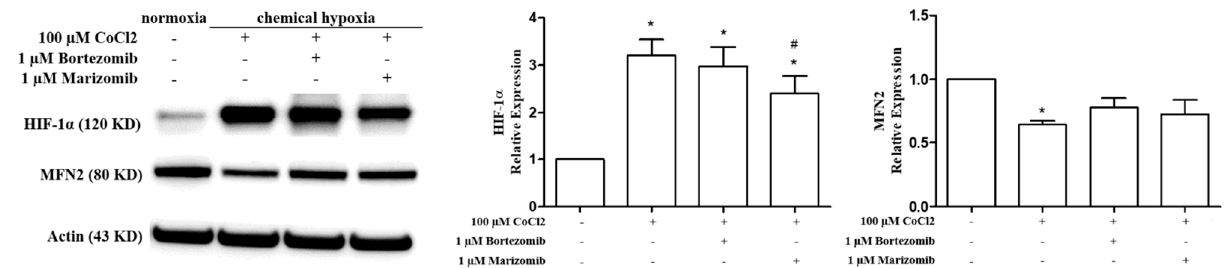
Figure 4. Proteasome inhibitors cannot obviously restore the expression of MFN2 inhibited by chemical hypoxia. HPASMCs were pretreated with 100 µ M CoCl 2 for 2 h, followed by bortezomib or marizomib for 24 h. The expressions of HIF-1 α and MFN2 were detected by Western blotting. Equal loading was confirmed with an anti-actin antibody. The expressions of HIF-1 α in the CoCl 2 alone group, the CoCl 2 plus bortezomib group, and the CoCl 2 plus marizomib group were higher than those in the normoxia group, and the expression of MFN2 was lower than that in the normoxia group. A one-way ANOVA was used to determine the differences between the experimental and control groups, and the Newman–Keuls Multiple Comparison Test was used as a post hoc test following the ANOVA. Data are represented by means ± standard error of three independent experiments. * p < 0.05 vs. normoxia group. # p <0.05 versus the CoCl 2 alone group.